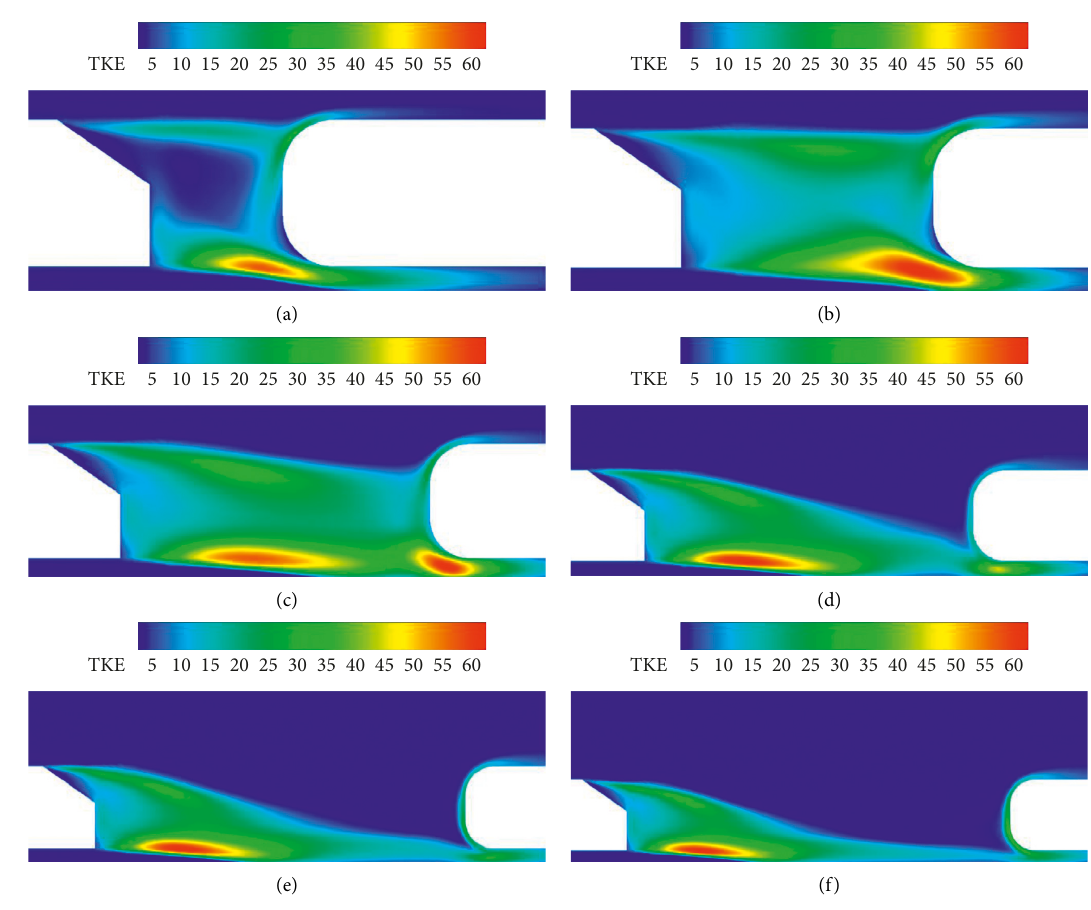
Figure 11: The distribution of TKE between two bodies at different inter-vehicle distances on the xz symmetry plane. (a) x/L � 0.25 (b) x/L � 0.5. (c) x/L � 0.75. (d) x/L � 1. (e) x/L � 1.25. (f) x/L � 1.5.